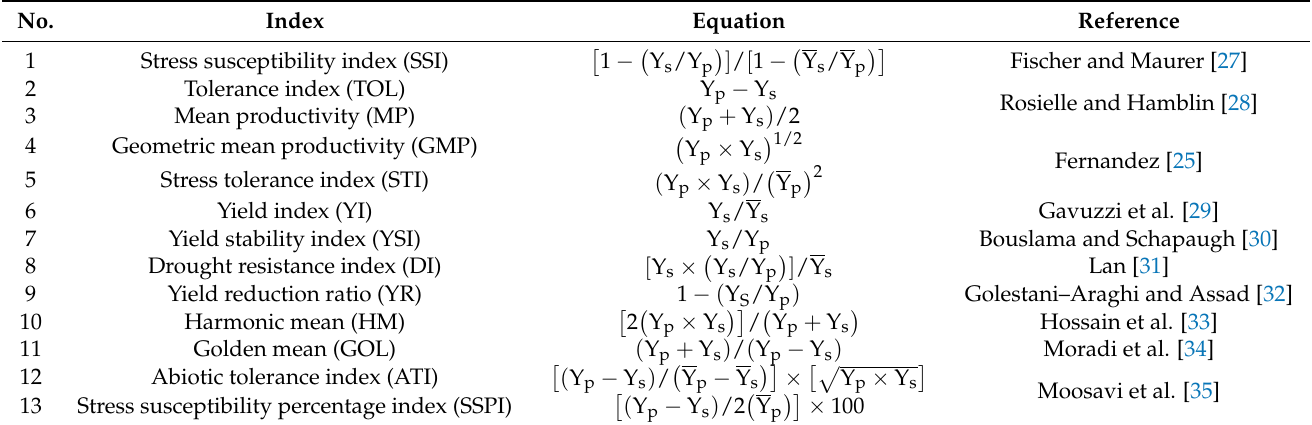
Table 3. Drought tolerance indices used for the evaluation of rice cultivars to drought